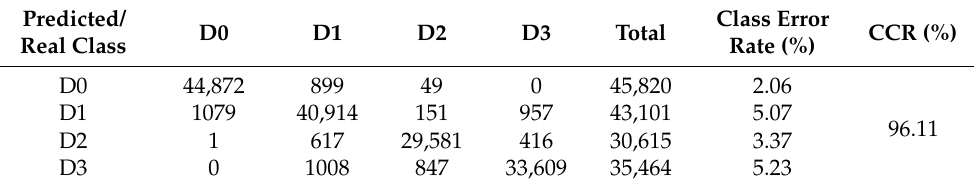
Table 4. Evaluation of the performance of the ANN-ICA classifier using the confusion matrix at 200 repetitions. D0: the day before applying excess nitrogen; D1, D2 and D3: one, two and three days after applying excess nitrogen, respectively.